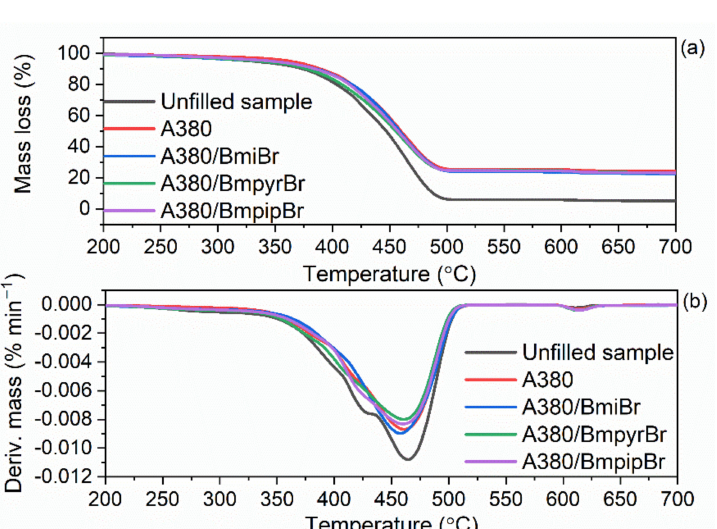
Figure 8. Thermogravimetric (TG) and derivative thermogravimetric (DTG) curves of SBR composites filled with silica A380: ( a ) TG curves; ( b ) DTG